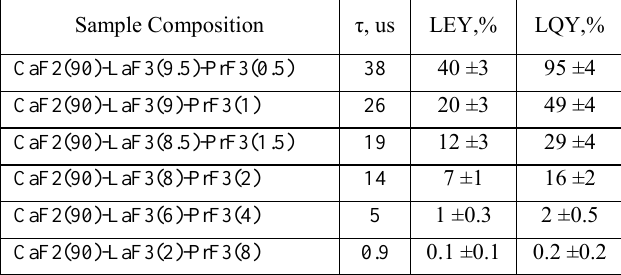
Table 1. Effective lifetimes, luminescence energy yield (LEY) and luminescence quantum yield of Pr 3+ ions 3 P 0 → 3 H j , 3 F j transitions in CaF 2 (90) -LaF 3 (10-x) -PrF 3 (x) disordered crystals. Sample